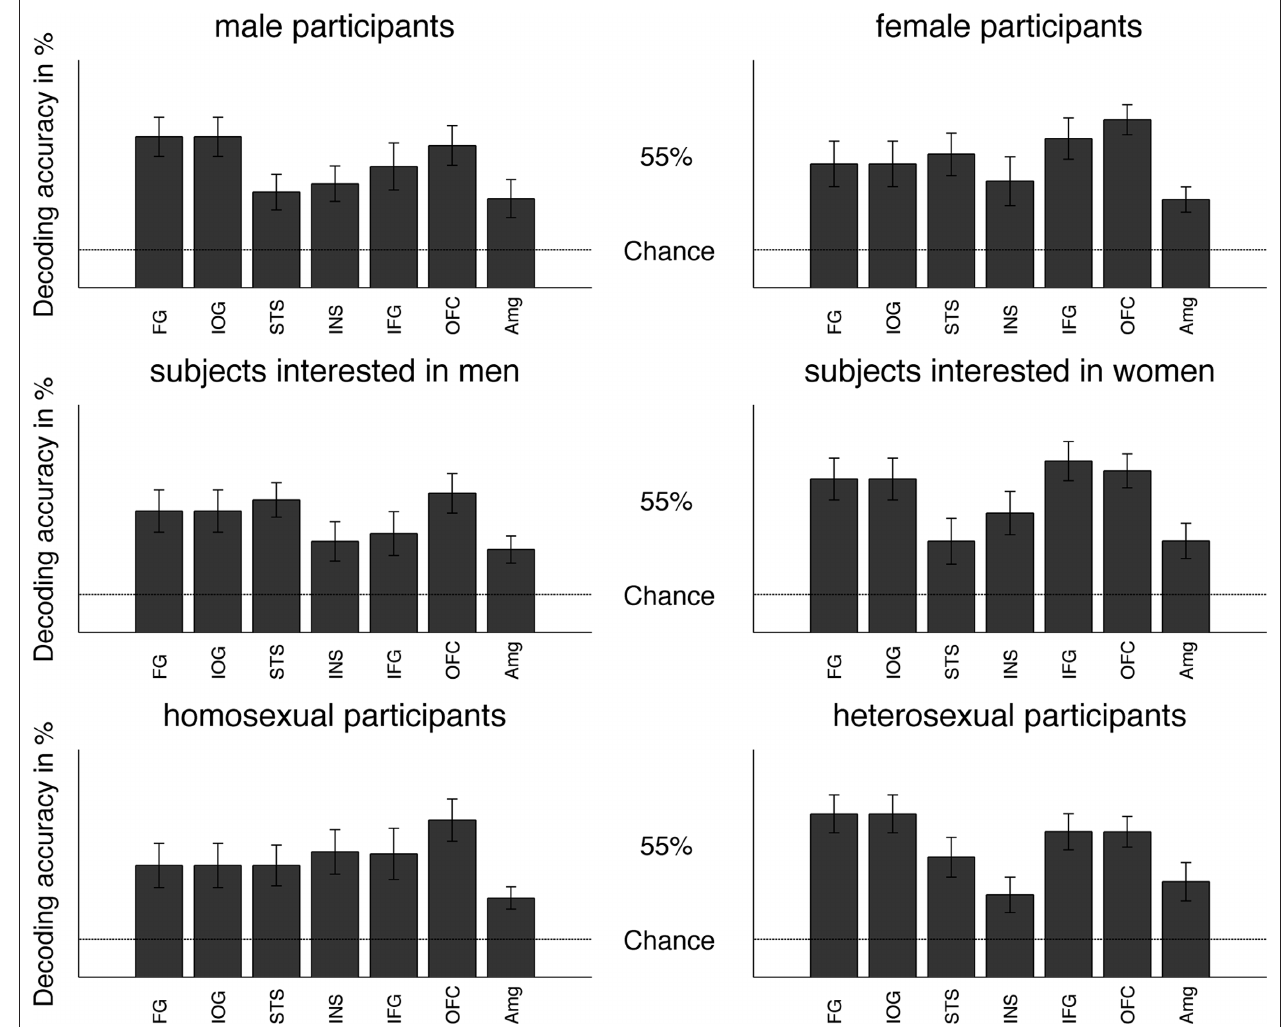
FIguRe A2 | Decoding performance in different sub-groups of participants. Top: male and female participants. Middle: participants interested in men and participants interested in women. Bottom: hetero- and homosexual participants. Overall differences in decoding performance between subgroups were tested with separate Student’s t -tests for each ROI and constellation of groups. However, no significant differences were revealed after correcting for multiple comparisons (see Table A2